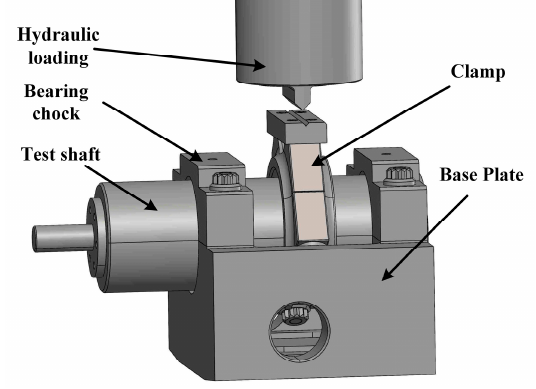
Figure 12. Schematic diagram of the loading structure.